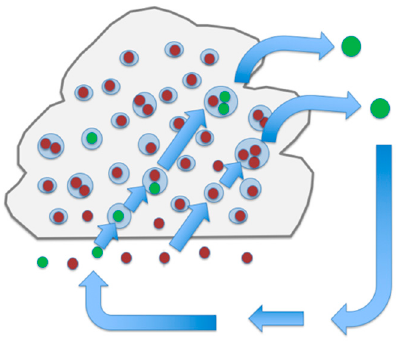
Figure 1. Schematic display of the treatment of cloud processing of aerosol particles in the model (initial “pristine” particles in red and “cloud-processed” particles in green).